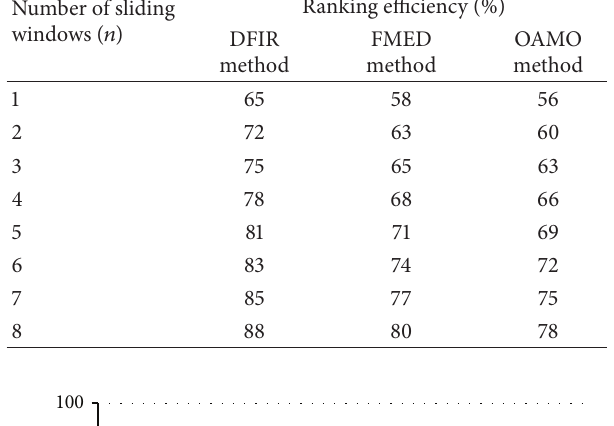
Figure 5: Measure of specificity.